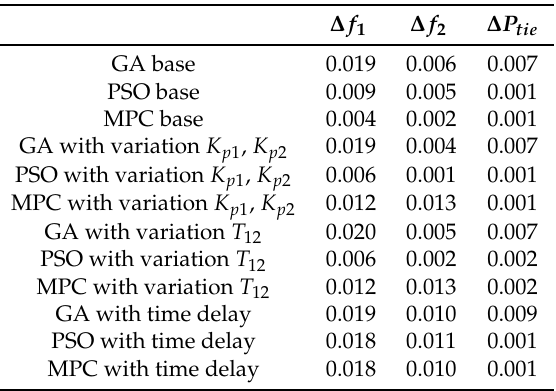
Table 3. Dynamic response comparison in terms of peak overshoot.